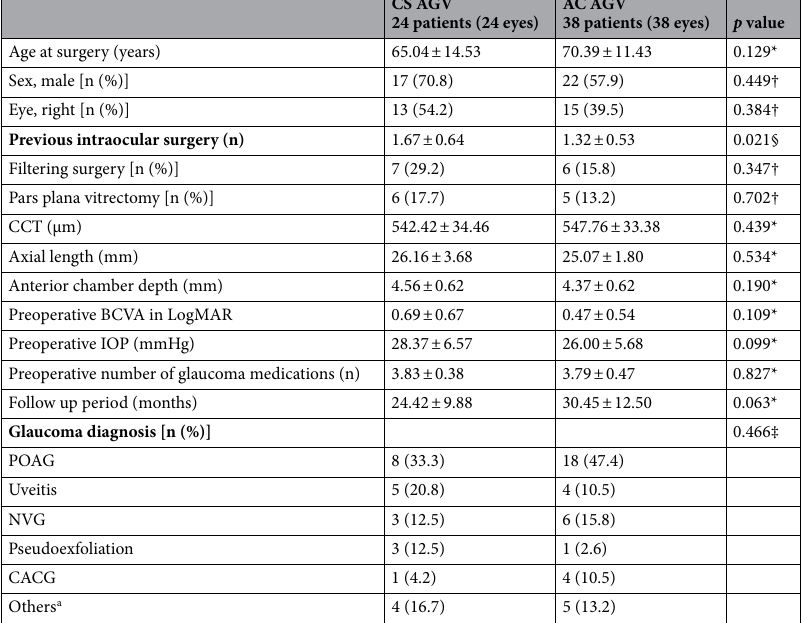
Table 1. Preoperative demographics for ciliary sulcus Ahmed valve and anterior chamber Ahmed valve groups. CS AGV ciliary sulcus Ahmed glaucoma valve, AC AGV anterior chamber Ahmed glaucoma valve, CCT central corneal thickness, BCVA best corrected visual acuity, IOP intraocular pressure, POAG primary open angle glaucoma, NVG neovascular glaucoma, CACG chronic angle closure glaucoma. *Mann–Whitney test; † χ 2 test; ‡Fisher’s exact test. § p < 0.05. a Other glaucoma diagnoses include angle recession glaucoma, steroid-induced glaucoma, mixed-mechanism glaucoma, and lens-induced glaucoma. Values are presented as the mean ± standard